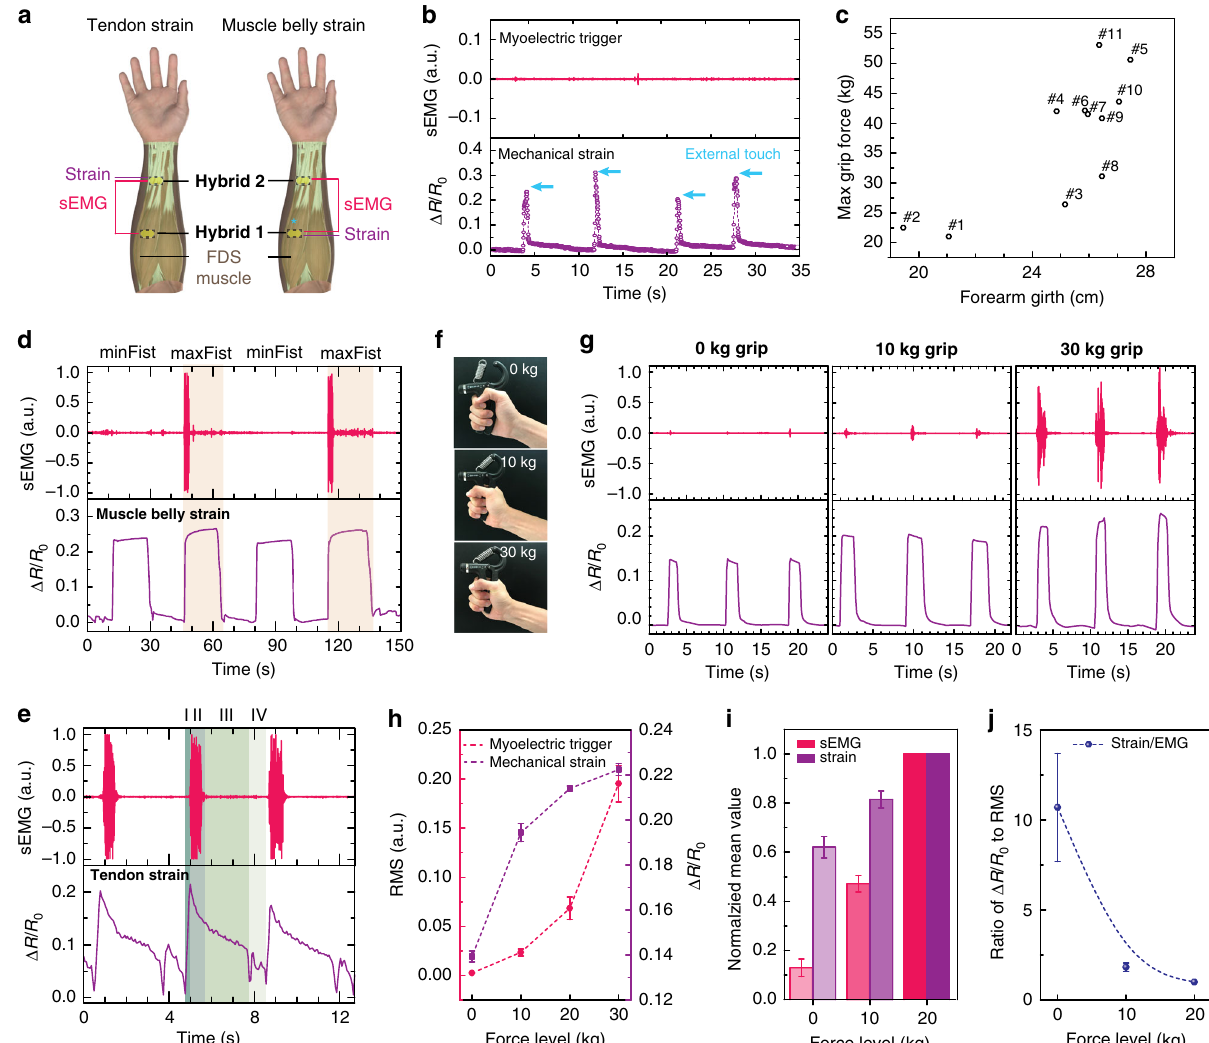
Fig. 4 Identi fi cation of muscular excitation – contraction signatures. a Schematic of a pair of CoupOn (hybrid 1 and 2) along fl exor digitorum super fi cialis (FDS) muscle, with hybrid 1 at the FDS belly as the muscle belly strain sensor or hybrid 2 at the FDS origin as the tendon strain sensor. b Graph shows that resistive strain sensing of CoupOn incurred little in fl uence on sEMG recording. In the case of passive external touch, the strain was detected without sEMG artifacts. c Circle plot shows biometrics of 11 subjects. d Plots show the local coupling of sEMG recording with resistive strain sensing that distinguished a minFist (minimal voluntary contraction) from a maxFist (maximal voluntary contraction). Representative of fi ve tests. e Plots show the electromechanical coupling during the maxFist using the tendon strain sensor. In contrast to d , the excitation – contraction signatures comprised four distinct phases as follows: (I) Fist closing, (II) Fist tightening, (III) Fist relaxing, (IV) Fist opening. Data obtained on subject 9. f , g Photographs and plots showing the excitation – contraction signatures of hand grips at force levels of 0 kg, 10 kg, and 30 kg, respectively. h Plots show that both root mean square (RMS) of sEMG signals and resistive strain sensing increased with force levels. Strain sensing appeared more sensitive to the force increase in the lower end, while sEMG seemed more responsive to the force increase in the higher end. Data obtained on subject 5. i Bar chart shows the normalized mean RMS of sEMG and resistive strain signals. j Plot shows the ratio of normalized resistive strain signals to sEMG RMS. It suggests the local coupling ef fi ciency of myoelectric trigger and mechanical strain decreases with the force level. Data obtained from the 11 subjects and normalized using respective signal amplitudes at 20 kg grips. Data are presented as mean ± contrast, thumb extension caused little sEMG signals and the in Fig. 4a) as the tendon strain sensor, it responded differentially lowest strain ( Δ R / R 0 about − 0.01), as it was not driven by FDS to the motion of different fi ngers against a fi nger exerciser muscle. This difference identi fi ed by CoupOn was actually con- (Fig. 5a, b). Among the four fi ngers, index fl exion (subject 9) sistent with the fact that tendons for the ring and middle fi ngers caused relatively weak sEMG peaks (amplitude ~0.02), whereas are super fi cial to that of the index and little fi ngers (equally the fl exion of middle and ring fi ngers induced slightly stronger observed in subject 2; Supplementary Fig. 20). sEMG peaks (amplitude about 0.03 – 0.05). On the other hand, index fl exion showed moderate strain ( Δ R / R 0 ~ 0.02) with simple curve envelopes, whereas the middle fl exion exhibited a higher resistivity increase ( Δ R / R 0 ~ 0.05) with two sharp peaks and the ring fl exion caused a sharp resistivity decrease ( Δ R / R 0 about sEMG amplitude and frequency 53 . In 20 kg grips (Fig. 5c – e), slow − 0.06) with a broad band followed by a sharp inverse peak. By grips (above 2 s) generated relatively weaker sEMG signals (root